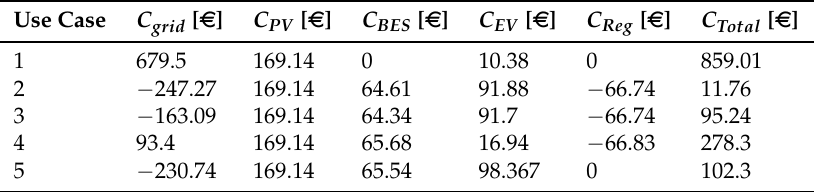
Figure 14. Cost breakdown for all 5 cases: Here, the black line indicates the total costs. Table 3. Cost comparison of the presented 5 use